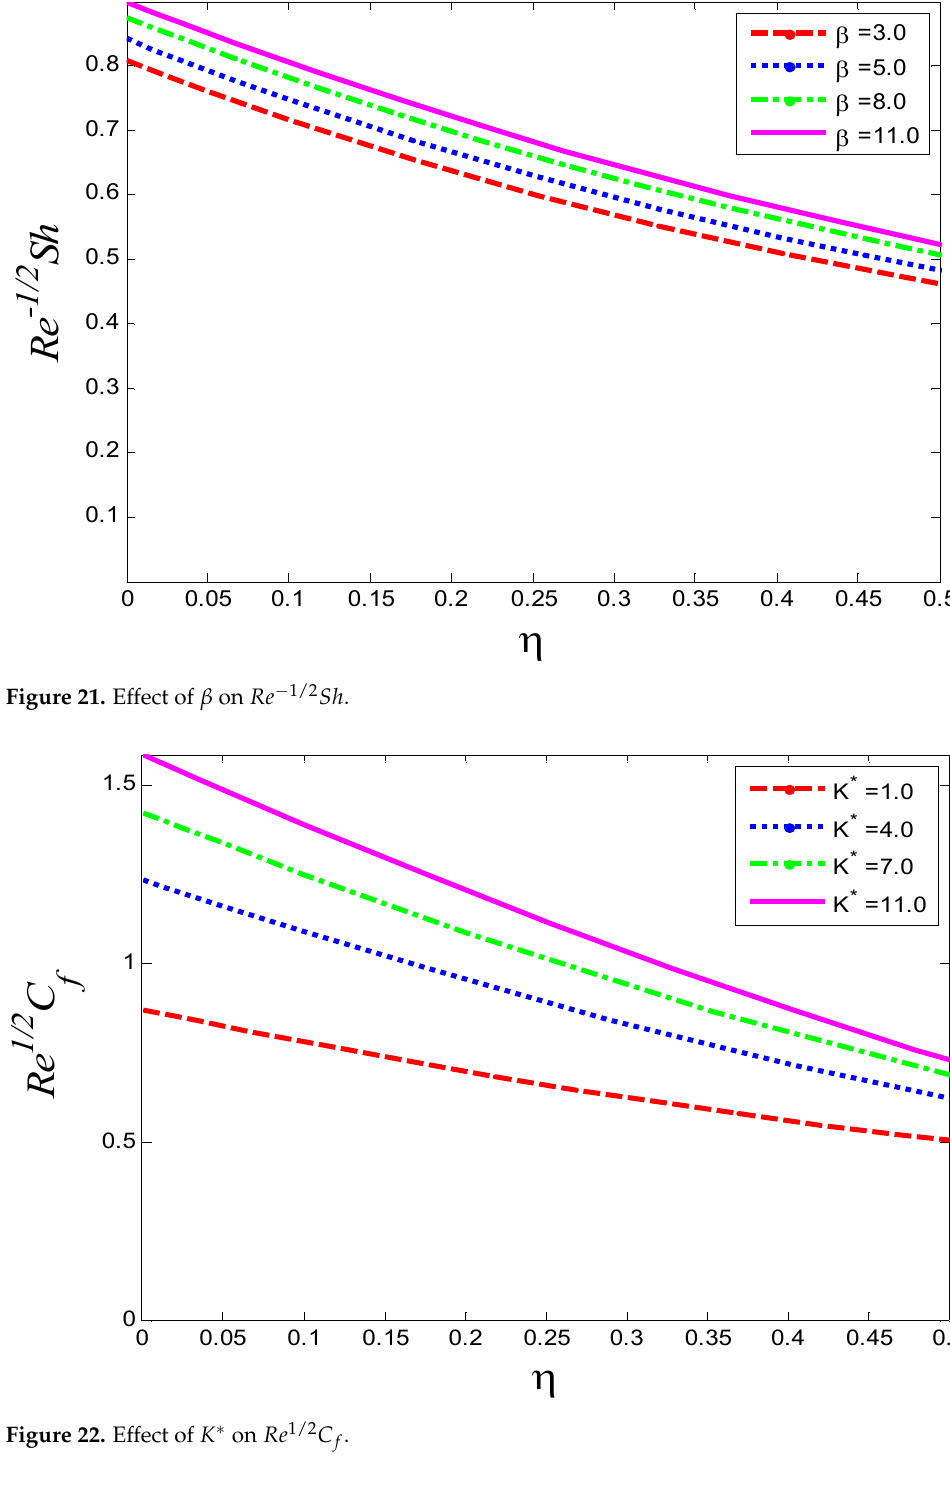
Figure 20. Effect of 𝛽 on 𝑅𝑒 (cid:2879)(cid:2869)/(cid:2870) 𝑁𝑢 .